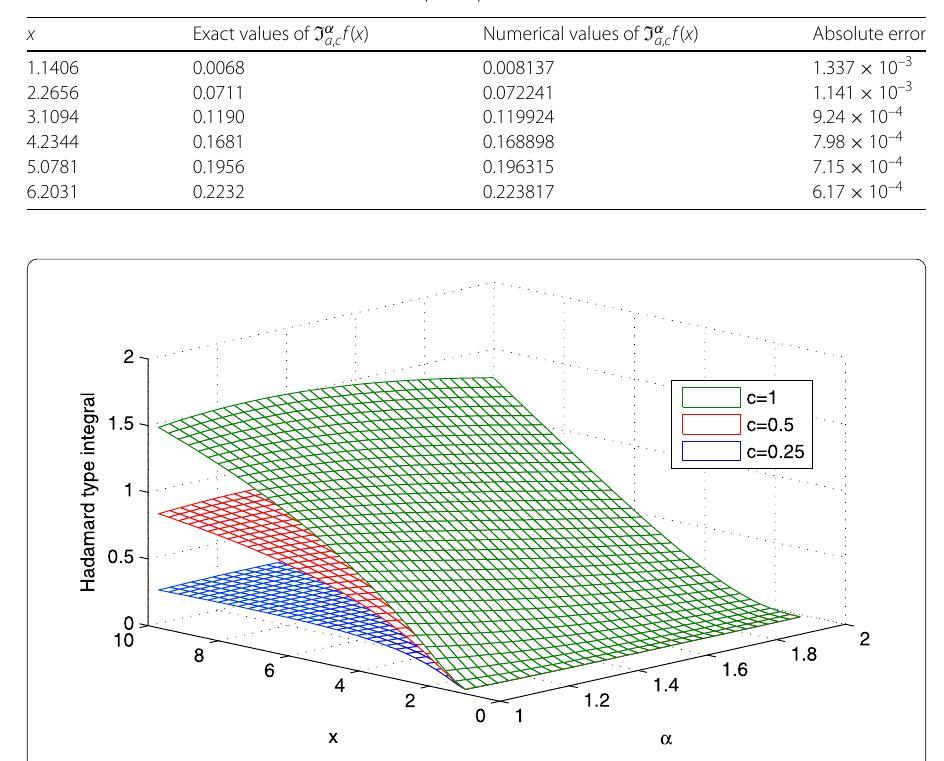
) α —Numerical integration (1 ≤ α ≤ a